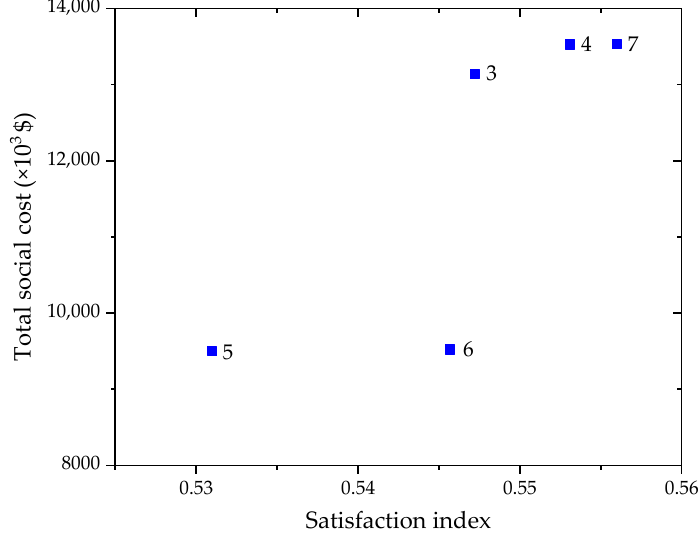
Figure 15. The total social cost and satisfaction index.